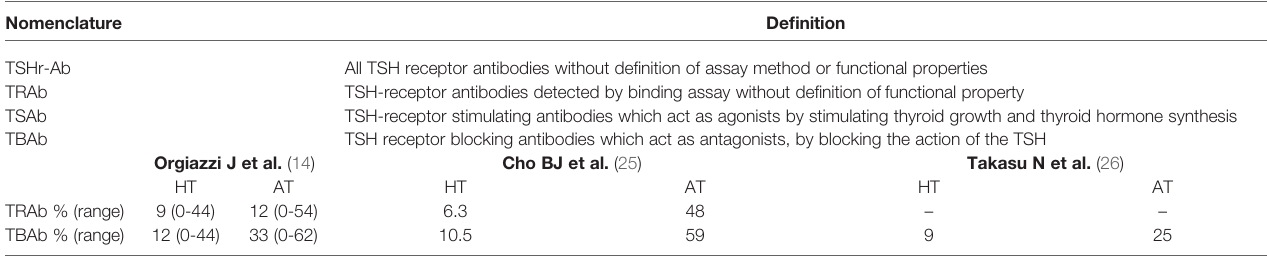
TABLE 1 | Nomenclature of TSH-receptor antibodies and Prevalence of TRAb and TBAb in Hashimoto ’ s thyroiditis and atrophic thyroiditis according to previous